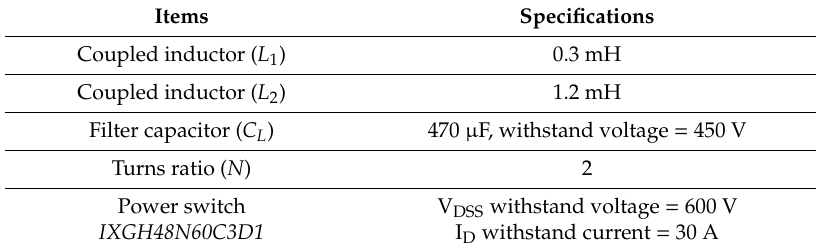
Table 2. Specifications of the components of high-boost / buck-ratio bidirectional converter.